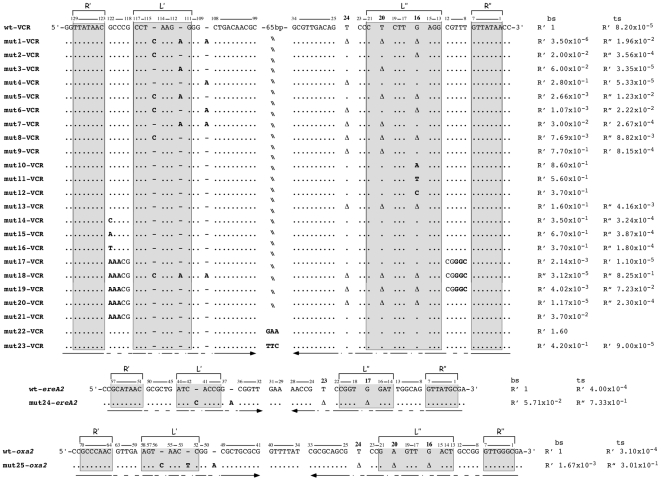
Sequence alignment of the attC mutant sites, and their recombination properties.The bs sequences of the wild type VCR2/1 (wt-VCR), attCereA2 (wt-ereA2), and attCoxa2 (wt-oxa2) sites are shown, and the respective position of each nt is numbered, with position 1 as the last nt of the R″ box. Bold numbers identify the position of the EHBs. For the mutant sites, a point corresponds to an unchanged nt, Δ represents a deleted nt, and a bold letter is an exchanged nt. The R', L', L″, and R″ boxes are highlighted by grey boxes. The recombination frequencies obtained after injection of the attC-bs (first column) or the attC-ts (second column) are normalized with the wt-attC-bs frequency and represent a mean of three independent experiments. The location of the recombination events, R' or R″, were determined (see Materials and Methods and Figure 4). The arrows, below each scheme, show the R', L' and L″, R″ arms.